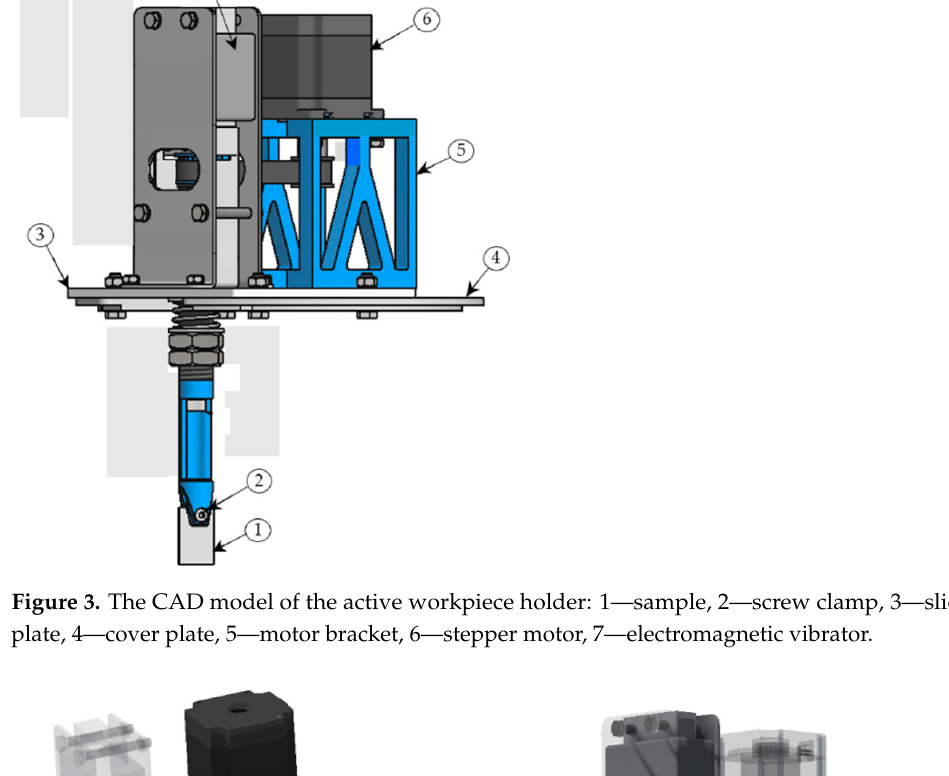
Figure 4. Two main kinematic units of the active holder: rotary ( a ) and vibration ( b ) motion of the Table 1. Nominal chemical composition of the AISI 304 steel (in active holder.